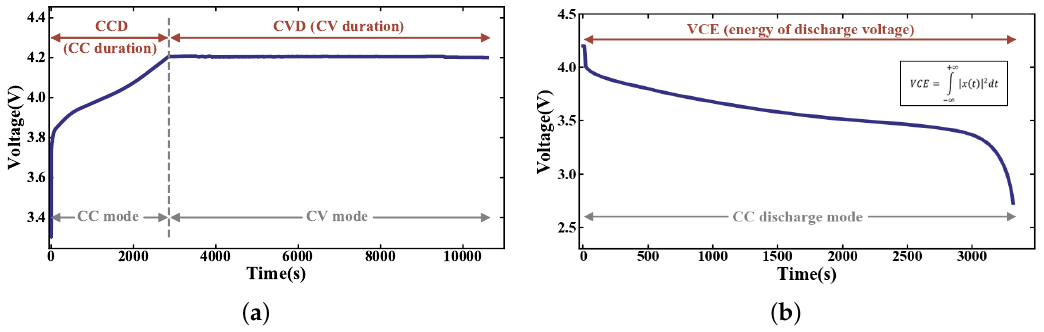
Figure 2. ( a ) Graphical representation of the features CCD and CVD in the charge curve. ( b ) Extraction method of feature VCE in the discharge